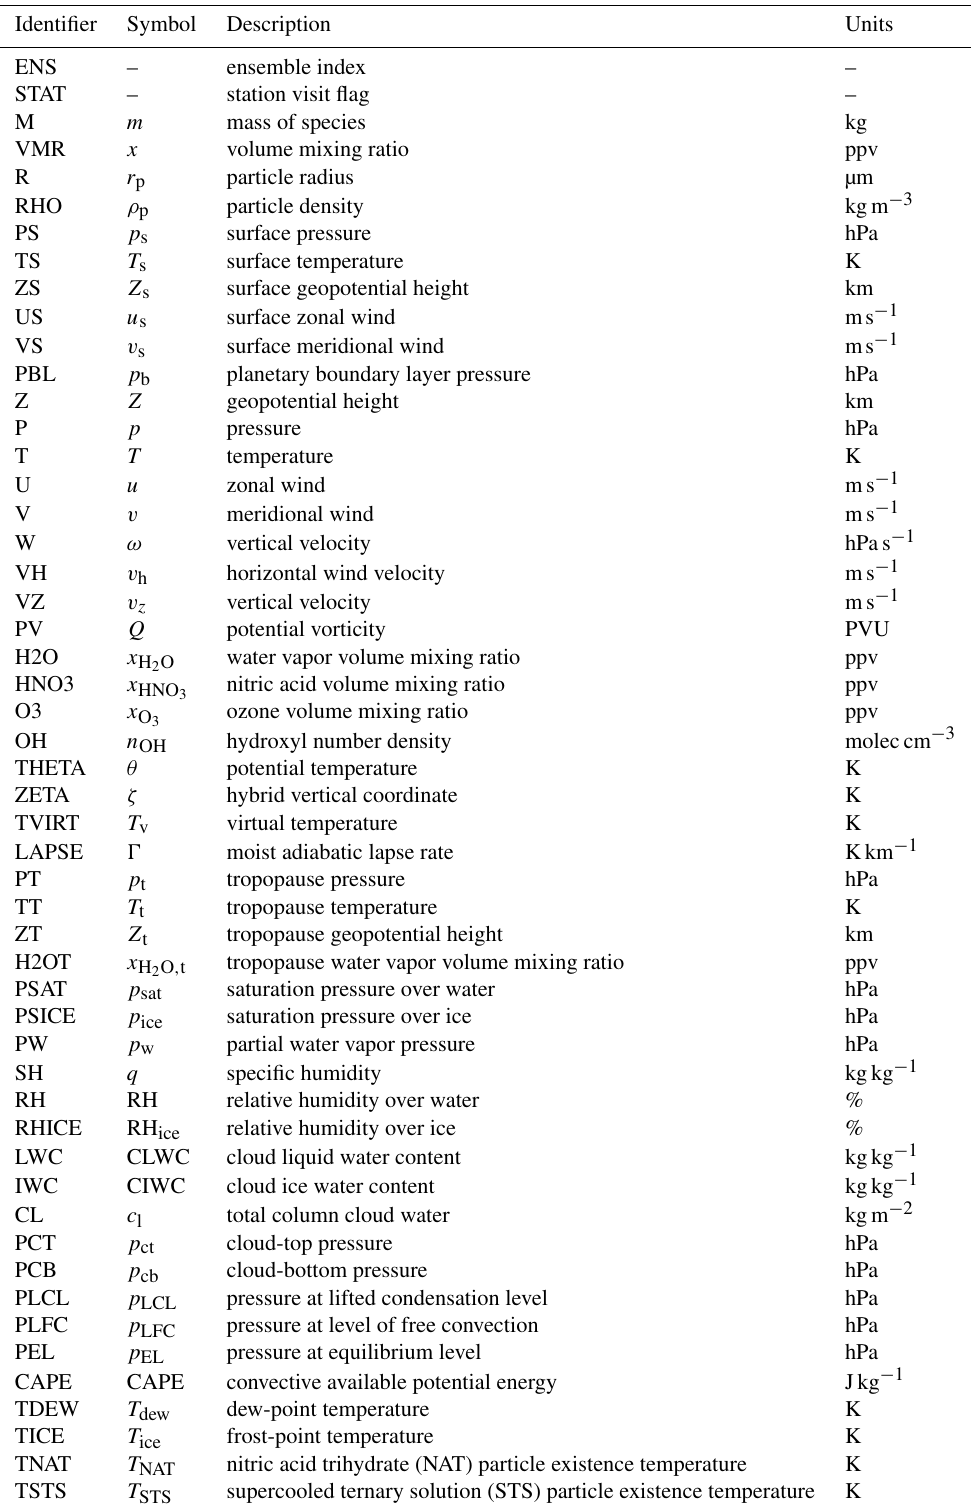
Table 4. List of quantities defined in MPTRAC. Identifier Symbol